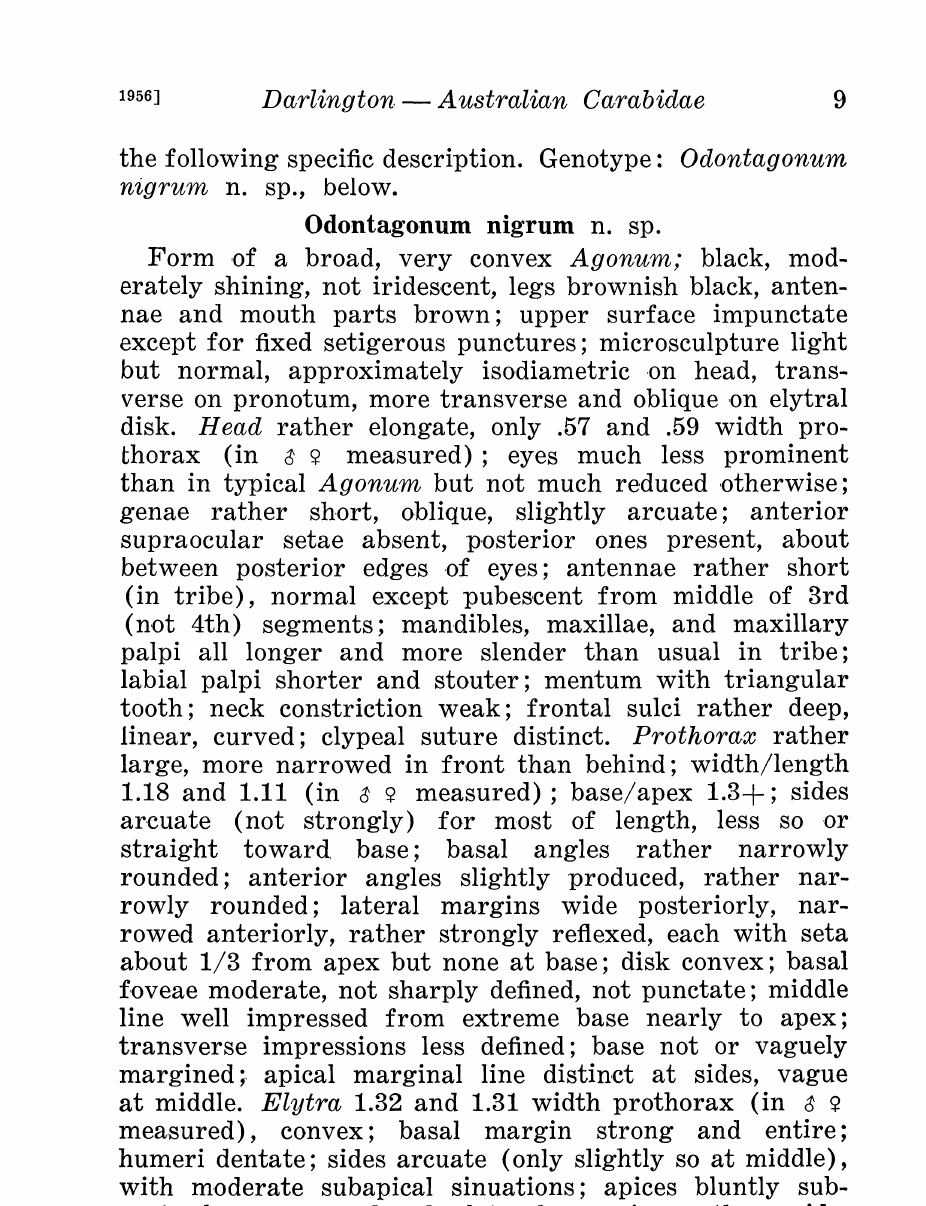
the following specific description. Genotype: Odontagonum nigrum n. sp.,